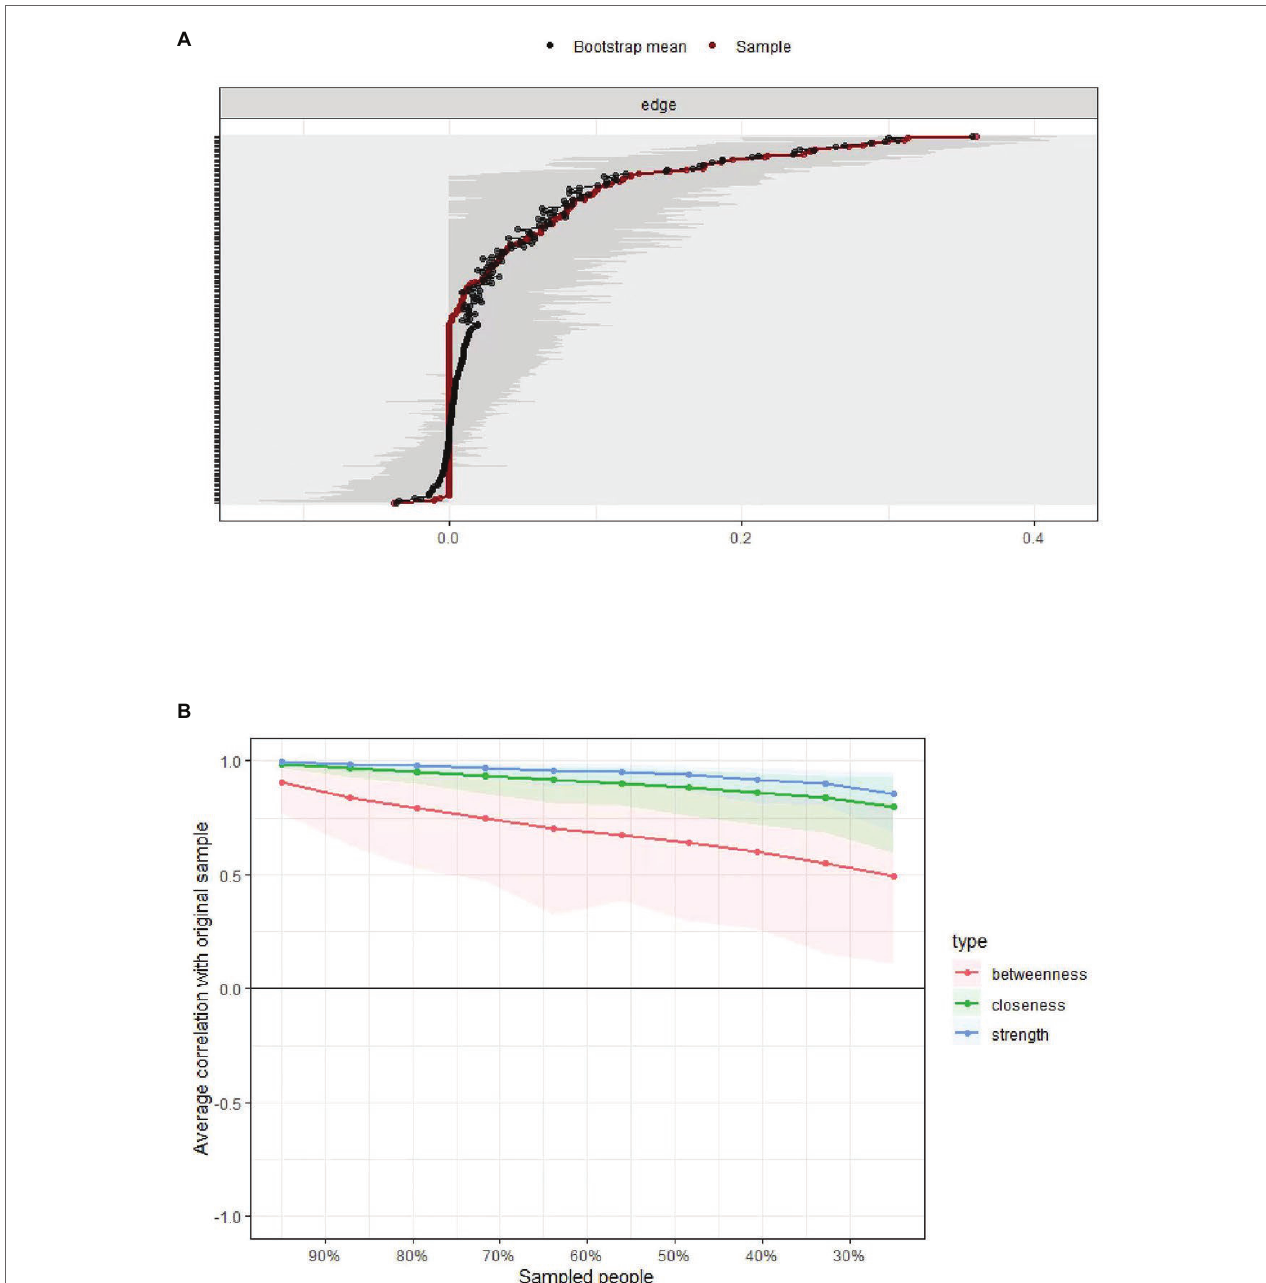
FIGURE 3 | Panel A : Bootstrapped confidence intervals (CIs) of the edge weights in the network. The red line indicates the edge weight values, the black line represents bootstrap means, and the gray area the 95% CIs. Panel B : Subsetting bootstrap for the network that shows the average correlations between centrality indices of the original network constructed on the full data, with networks estimated on samples with fewer